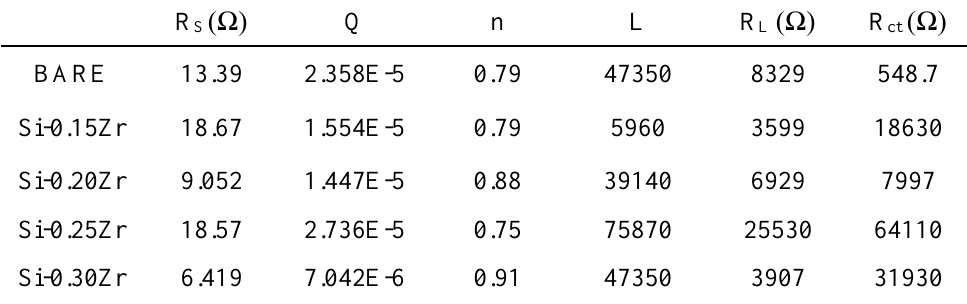
Table 2. Important parameters of EIS measurement